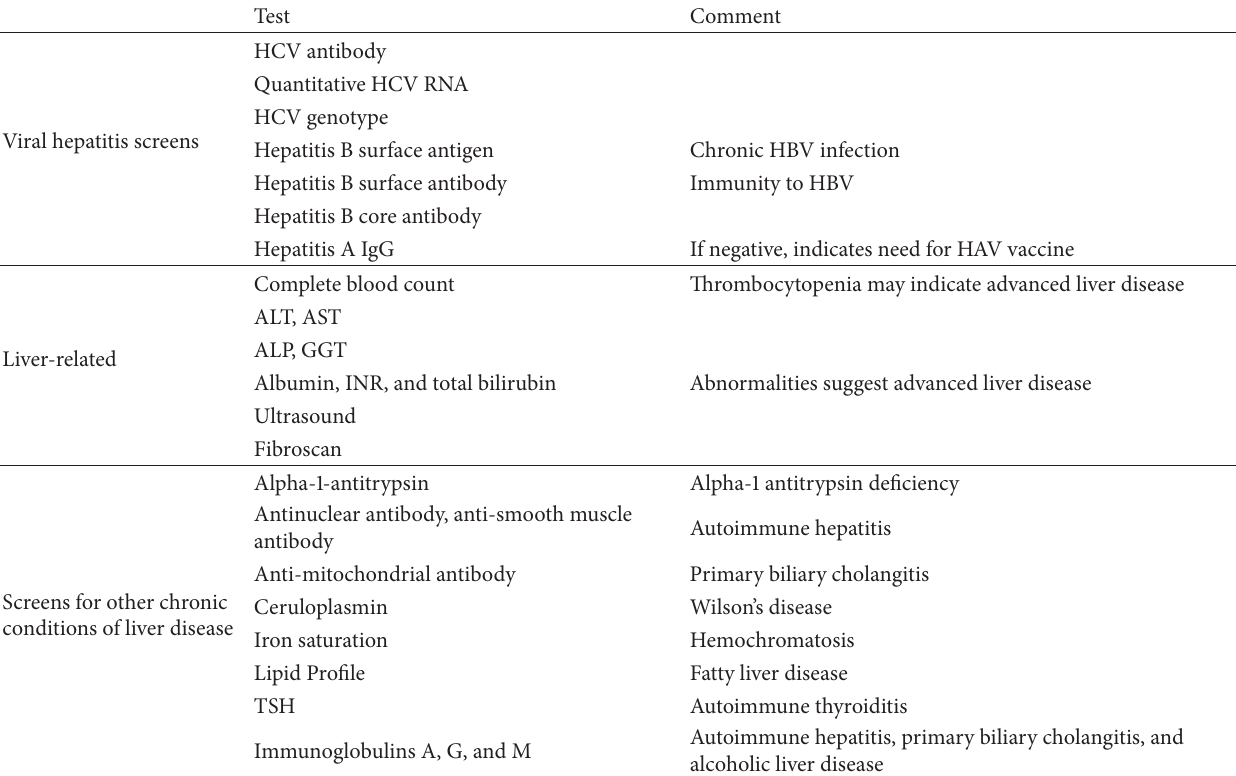
Table 2: Baseline assessment of coinfected